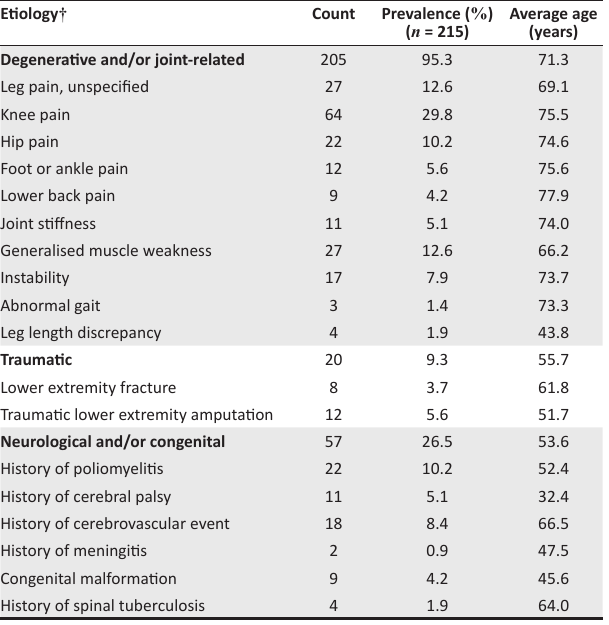
TABLE 3: Burden of musculoskeletal